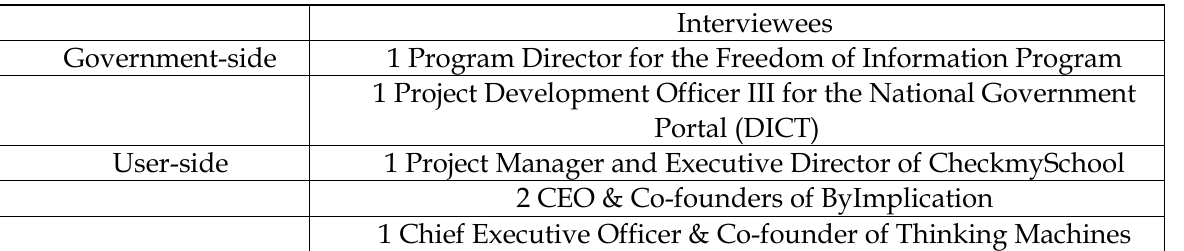
Table 3: Interview